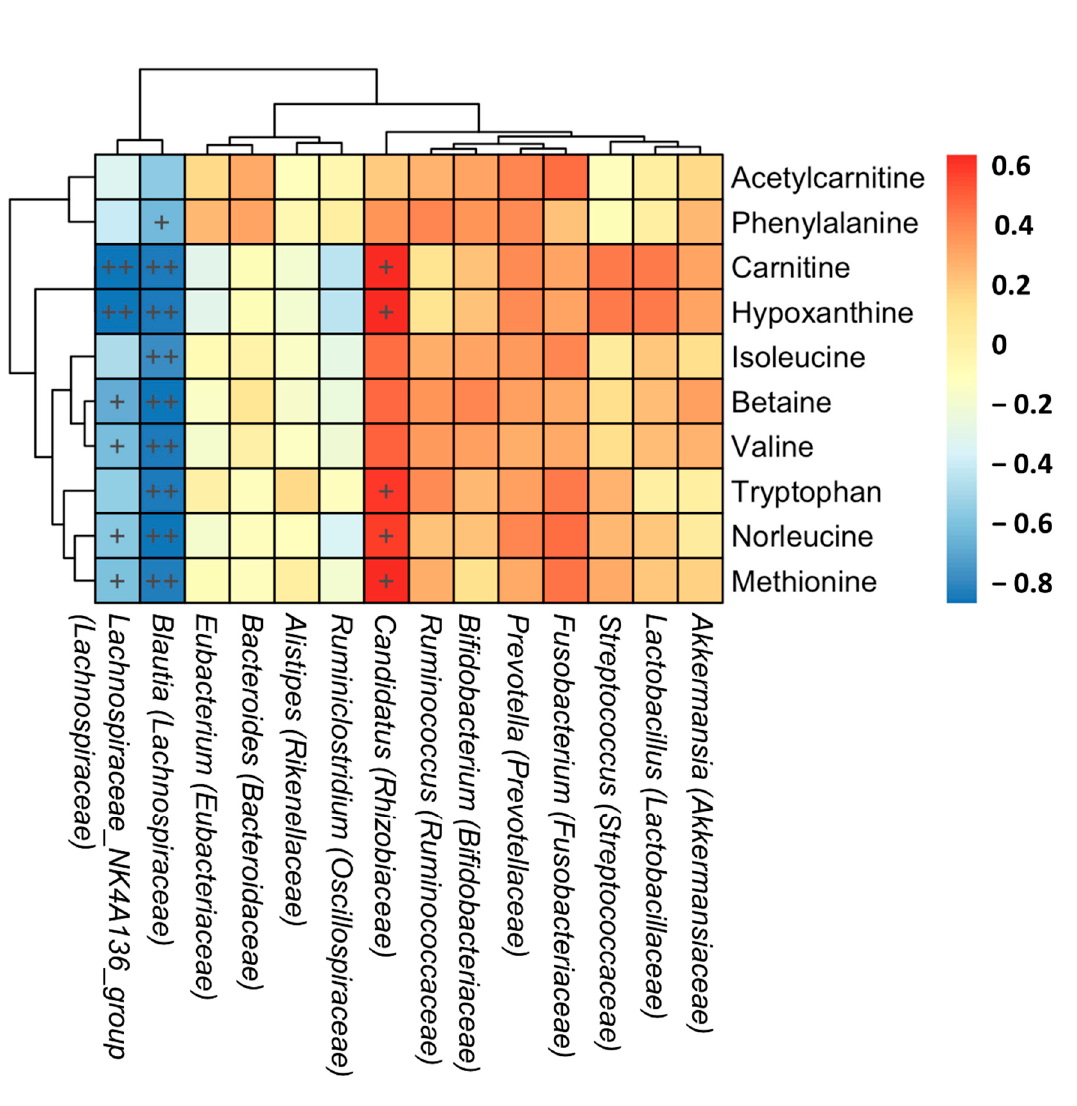
Figure 6. Heat map of correlations between the level of metabolites and microbiota composition. The heat map shows Spearman’s correlations between significantly changed genera of gut microbiota and selected serum metabolites between the control and Der p group. Color intensity represents the magnitude of correlation. Red represents positive correlations and blue negative correlations. + p < 0.05; ++ p <